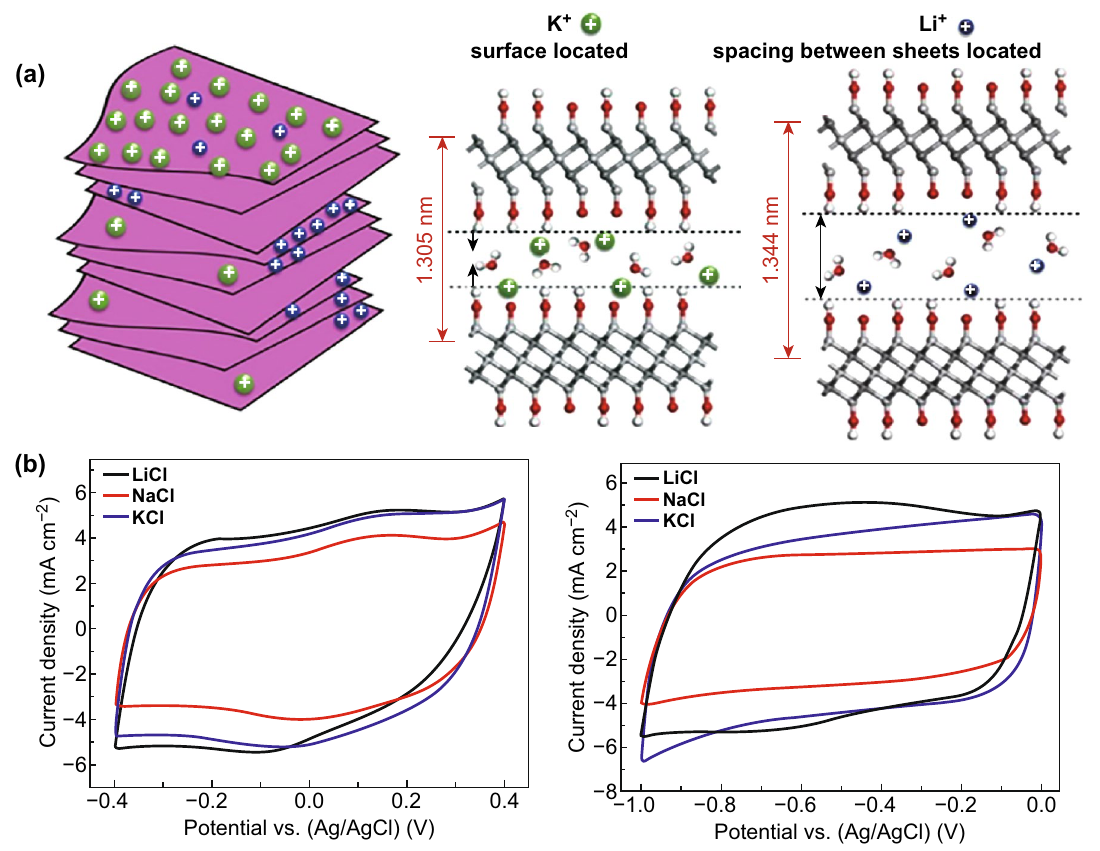
Fig. 3 Electrochemical performance of Ti 3 C 2 T x at a scan rate of 5 mV s −1 . a Schematic illustration of ionic intercalation mechanism on the sur- face of the Ti 3 C 2 T x . b CV curves of Ti 3 C 2 T x in aqueous LiCl, NaCl, and KCl electrolyte at different potential windows. Reproduced with permis- sion from Ref.